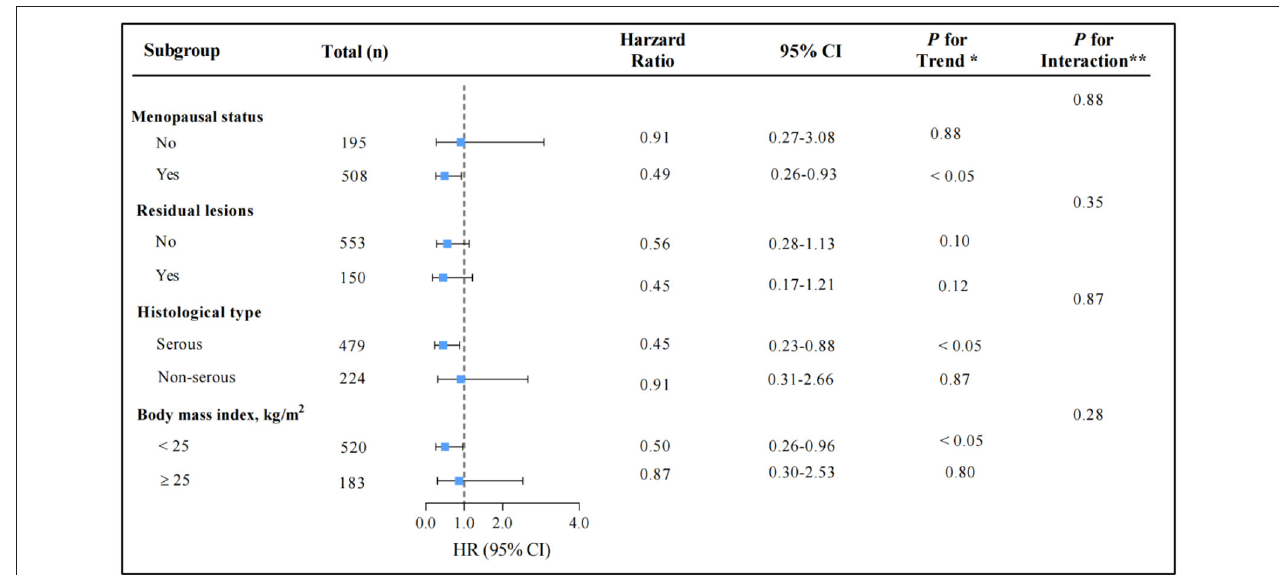
FIGURE 3 | Multivariable hazard ratios (HRs) and 95% CIs for overall survival among ovarian cancer patients across strata of various factors. The analyses used three categories of cruciferous vegetables intake (T 1 < 33.08, T 2 14.76–90.00, and T 3 ≥ 90.00 g/d). The forest plot represents the HRs of the comparison of the highest vs. the lowest of cruciferous vegetables intake. Cox model stratified by menopausal status, residual lesions, histological type, and body mass index, with additional adjustments for age at diagnosis, body mass index, comorbidities, diet change, education, FIGO stage, histological type, histopathologic grade, menopausal status, parity, physical activity, residual lesions, smoke status, meat, fruit, green leafy vegetables, allium vegetables, and total energy. *indicates P for trend across levels of cruciferous vegetables intake. **indicates P for interaction between strata and cruciferous vegetables intake. P -values are